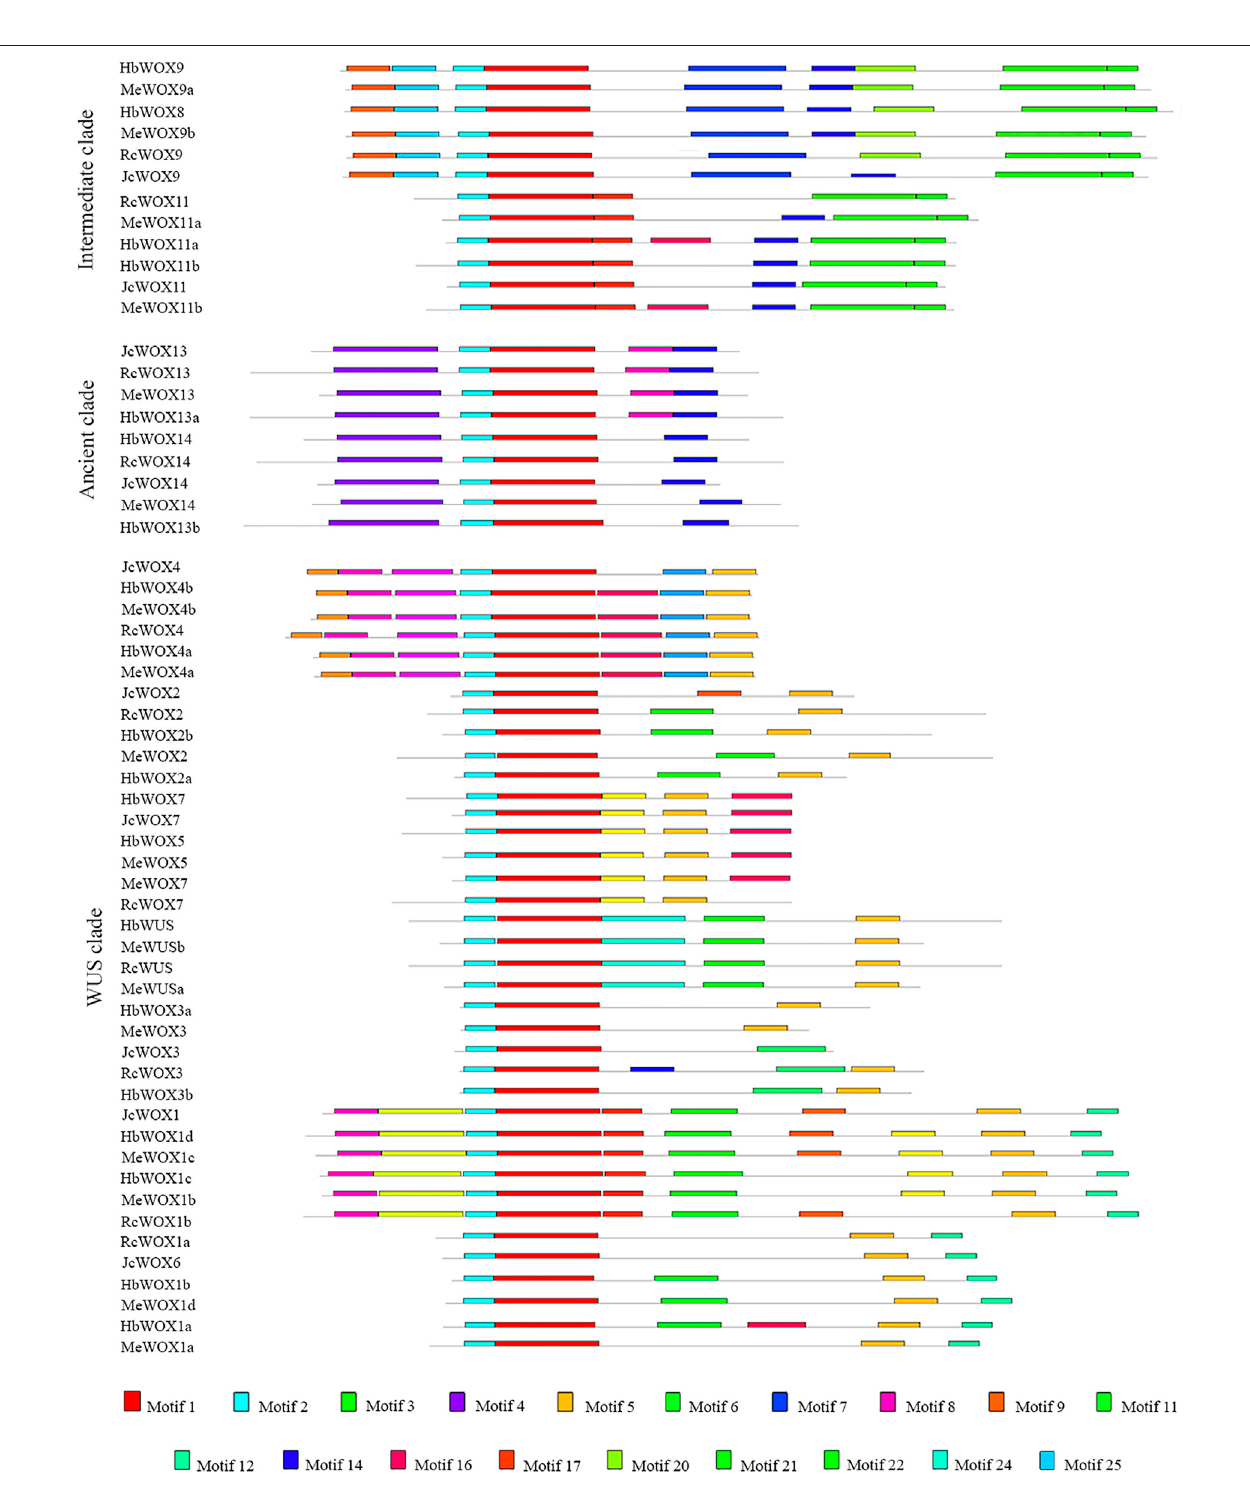
FIGURE 3 | Distribution of conserved motifs identi fi ed among four Euphorbiaceae species. 25 conserved motifs identi fi ed in 59 WOX proteins, which can also be divided into ancient, intermediate, and modern/WUS clades according to the phylogenetic tree.